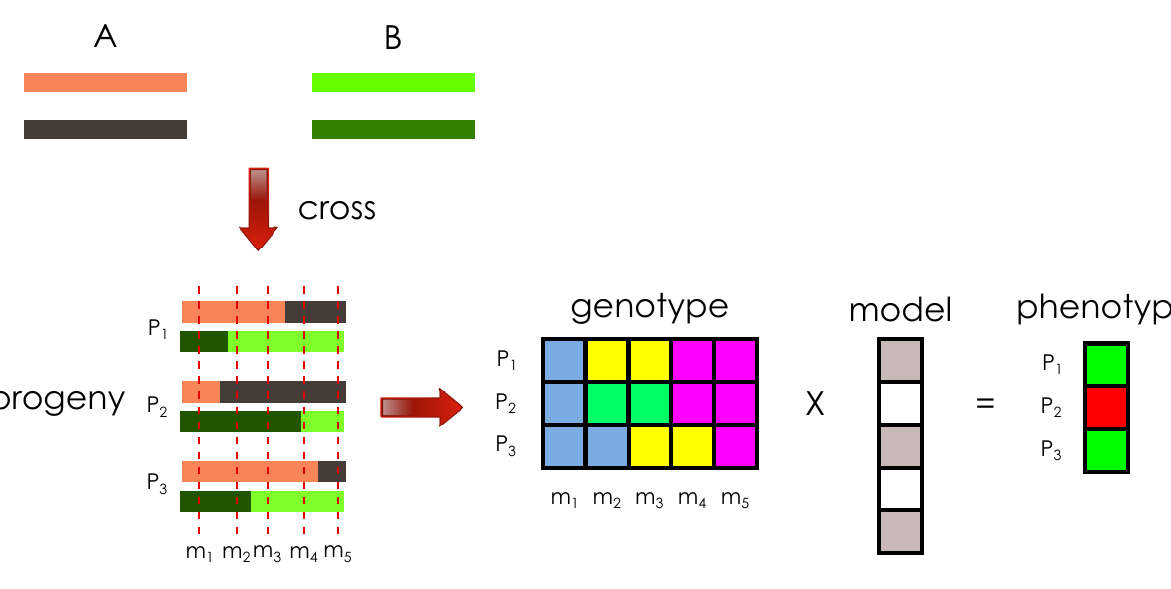
Figure 1. Illustration of the general problem setting. Crossing the diploid founder genomes, A and B , produces three progeny, P , P , P , and each progeny haploid has a single crossover 1 2 3 introduced in the meiosis, illustrated by the two different colors per haploid. The genotype , ..., m matrix for five markers, m , represents the aggregate of haploid information per 1 5 progeny, at specific genomic locations. Each progeny is assigned a phenotype value based on their genotype and a phenotype